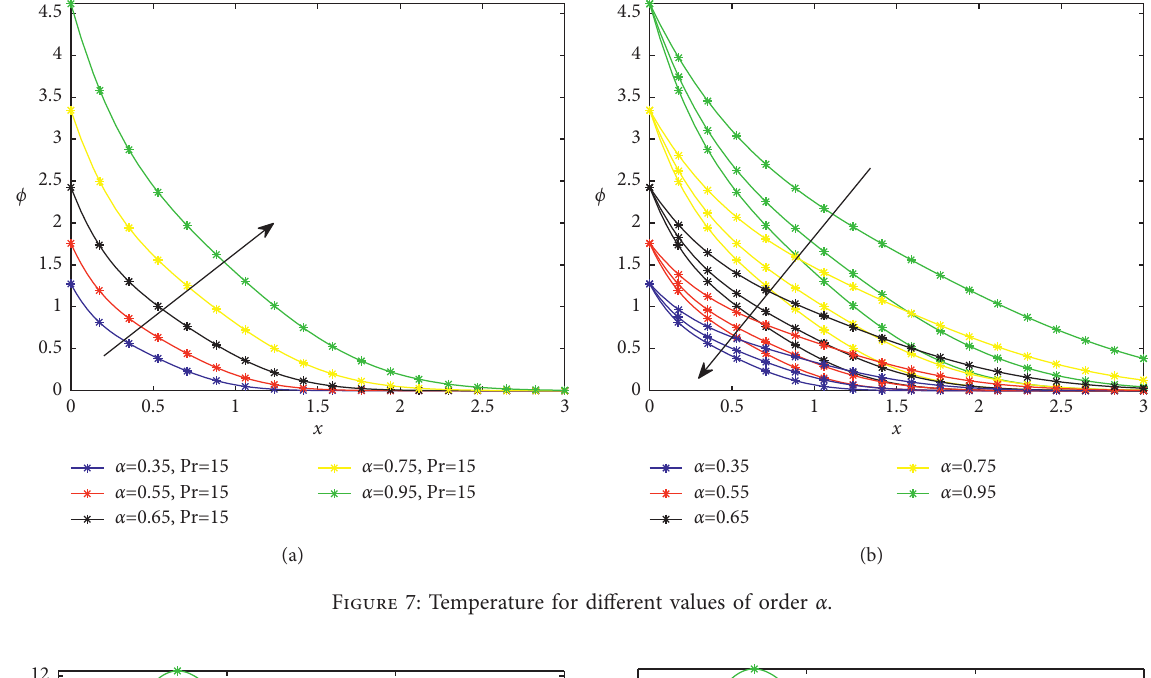
Figure 7: Temperature for different values of order α .